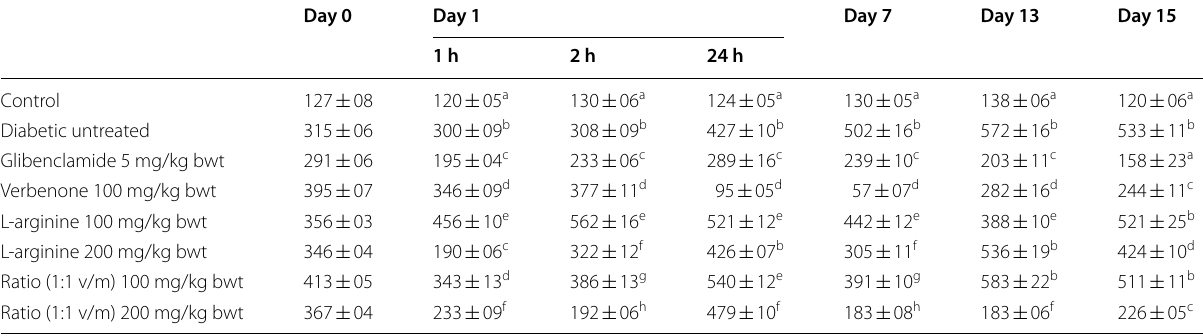
Values are mean Values with different superscript down the column are significantly different at p >